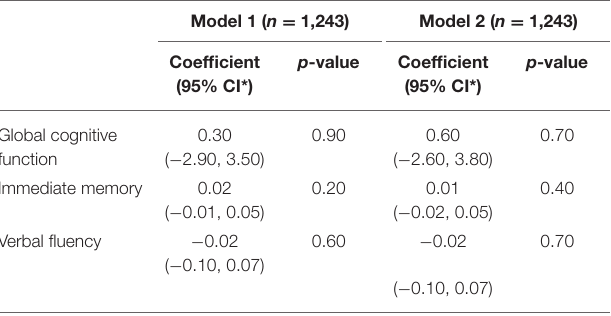
TABLE 3 | Multivariable regression models of cognition performance at follow-up on watching TV (hours/day) adjusting by the corresponding cognition metric at baseline (model 1); and adding sociodemographic characteristics and functional status at baseline (model 2).